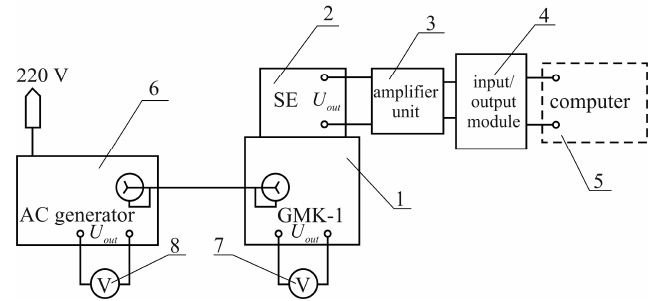
Figure 2. Schematic diagram of the test stand for the experimental investigation of piezoelectric SE: